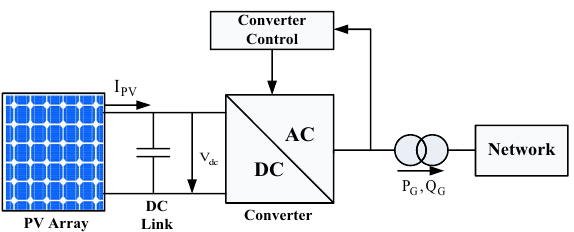
Fig. 1 A single unit PV generator with the control